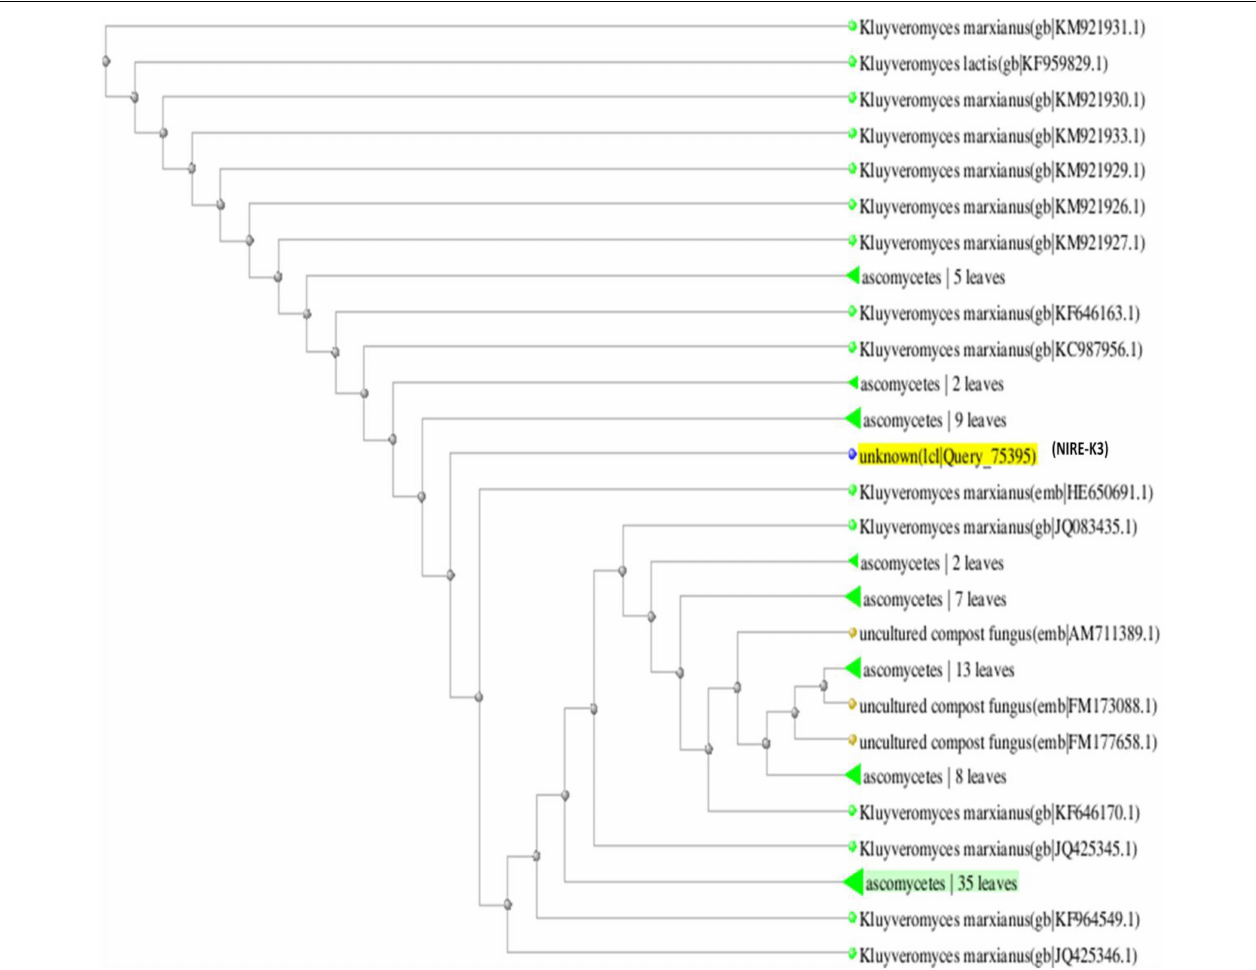
FIGURE 5 | Phylogenetic tree drawn through BLAST showing genetic relationship between K. marxianus NIRE-K3 and similar